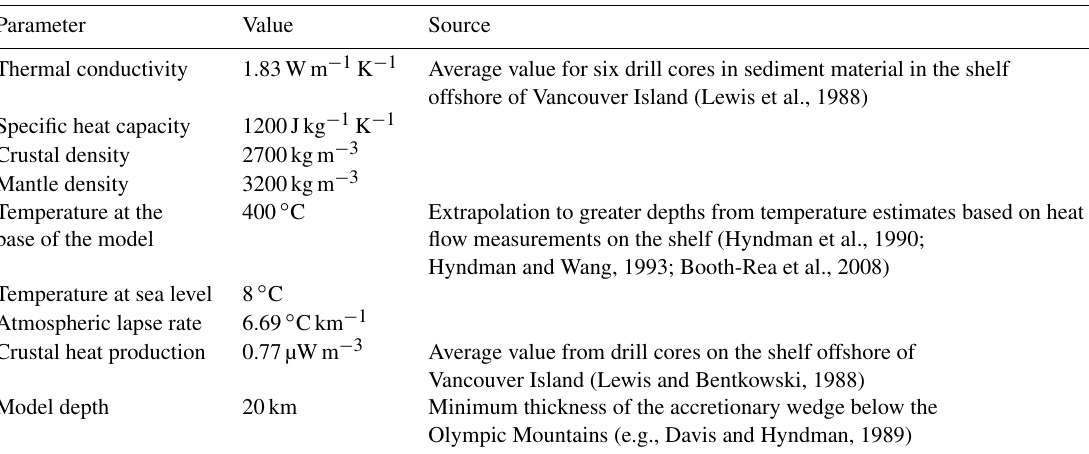
Table 4. List of parameters used for the Pecube modeling.